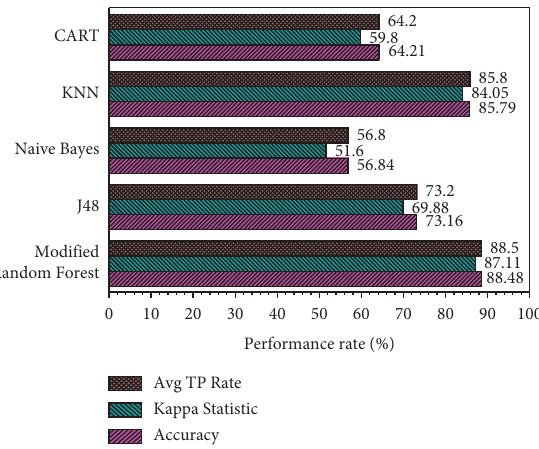
Figure 2: Average TP rate, kappa statistic, and accuracy for various models compared with modifed random forest